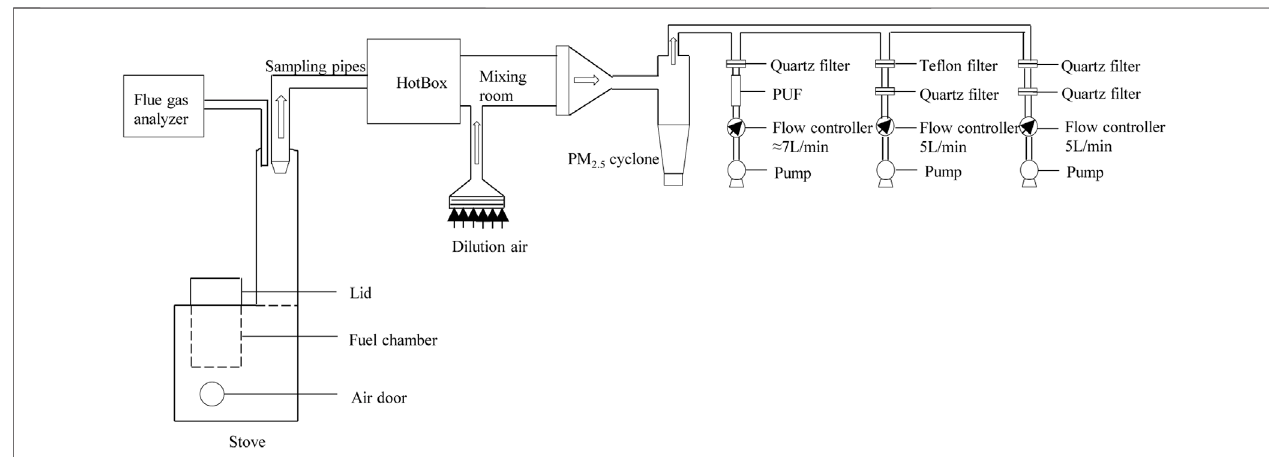
FIGURE 1 | Schematic diagram of the sampling system.